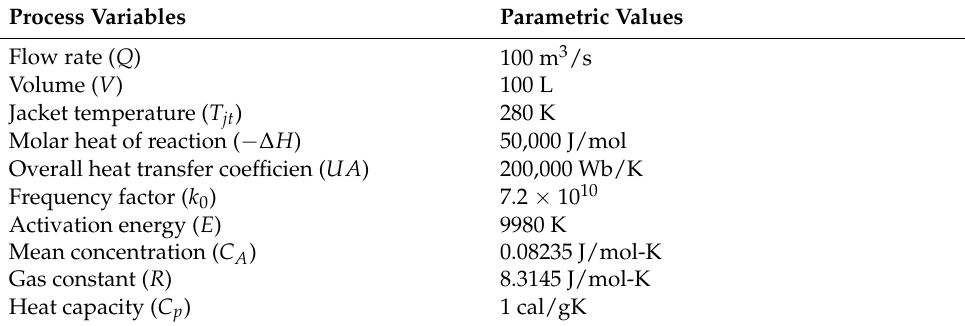
Table 2. Operating parameters of the reactor